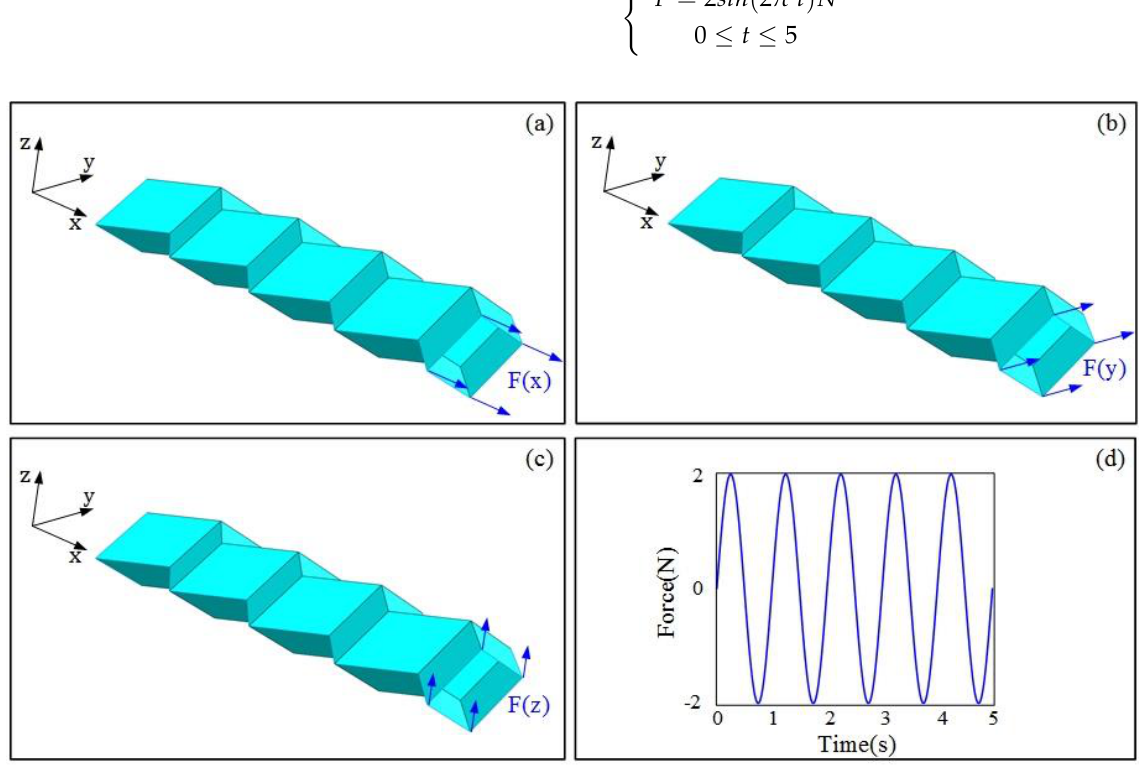
Figure 2. ( a – c ) illustrate the concentrated forces along the x , y , and z directions, respectively, acting on the four nodes at the free end. ( d ) The variation of periodic force.